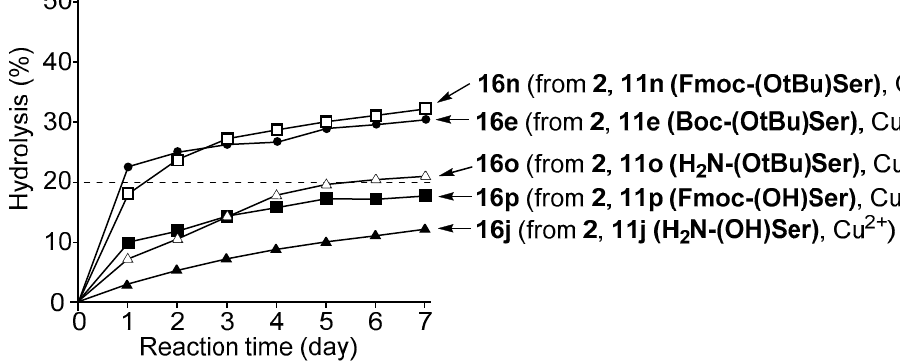
Figure 6. Hydrolysis of MNP (100 μ M in the total solution) by 16e (closed circles), 16j (closed triangles), 16n (open squares), 16o (open triangles), and 16p (closed squares) (barbital derivatives containing serine residue) ([ 16 ] = 20 μ M in the total solution) in CHCl 3 /50 mM HEPES buffer (pH 7.4) with I = 0.1 (NaNO 3 ) (2/8) at 37 °C. The concentrations of the product (4-nitrophenol) were determined in the total solution of the two-phase solvent system.